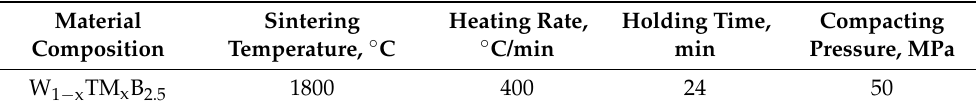
Table 2. Spark plasma sintering process parameters of W/B and W/Zr/B powder mixtures. Material Compo-